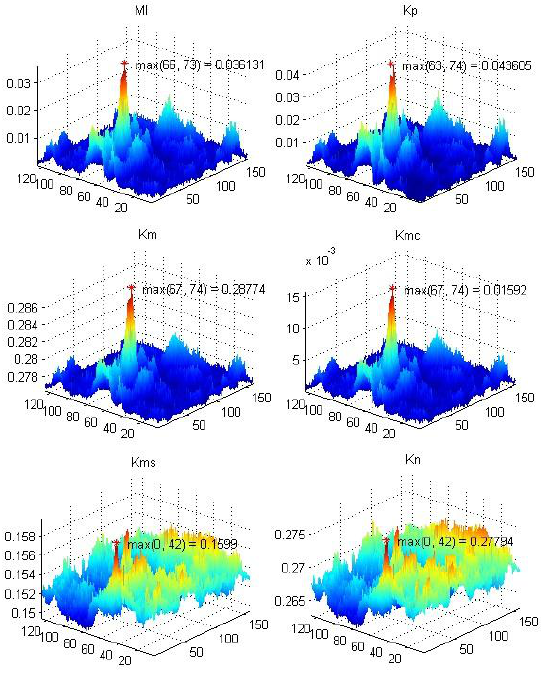
Figure 2. Correlation fields for TV-IR matching (Example 1).